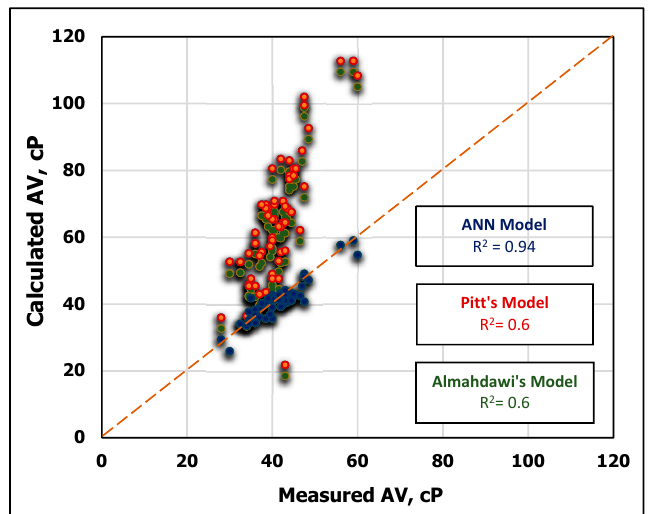
Figure 11. Comparison of predicted AV using Pitt's [54], Almahdawi’s et al. [55] and the developed ANN models.